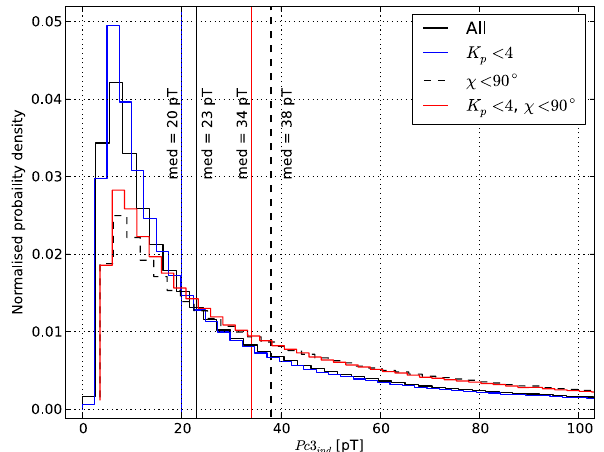
Figure 2. Distribution of Pc3 ind for the selection criteria listed in the legend. Vertical lines and numbers indicate the median of each selection.